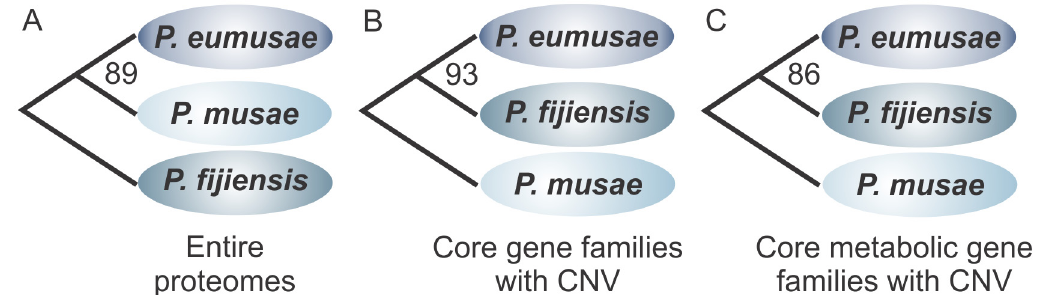
Fig 6. Hierarchical clustering of Pseudocercospora musae , Pseudocercospora eumusae , and Pseudocercospora fijiensis based on copy number changes in different groups of KOG gene families. Hierarchical clustering of the species based on (A) the KOG distribution profile (i.e. the number of genes assigned to each category of KOG) of their entire proteomes, (B) the KOG distribution profiles of the 575 core gene families with copy number variation (CNV), and (C) a subset of 190 core gene families with CNV that are predicted to be involved in metabolism based on KOG assignments. The reliability of the clustering patterns was assessed by bootstrap tests (1000 replicates) and obtained bootstrap values are indicated next to their corresponding branching nodes. While clustering of the species based on the KOG distribution profiles of the entire proteomes follows a pattern that is respective of the their phylogenetic relations (Fig 2), clustering of the species based on the KOG profiles of core gene families with CNV or their subset of gene families involved in metabolism, indicates a swapped topology in which P . eumusae is clustered together with P . fijiensis suggesting that these two species share a more similar pattern of gene family expansions and contractions.